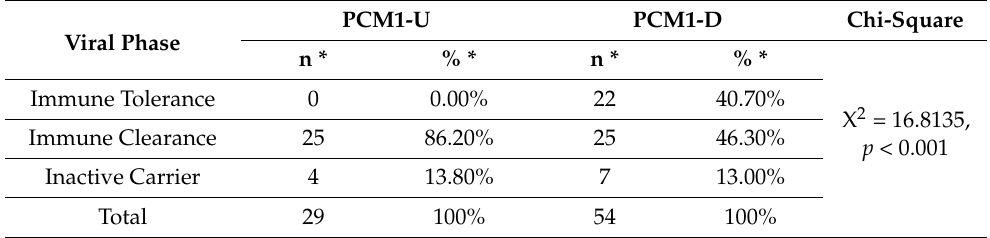
Table 3. Distribution of viral phases within PCM1-U and PCM1-D groups in